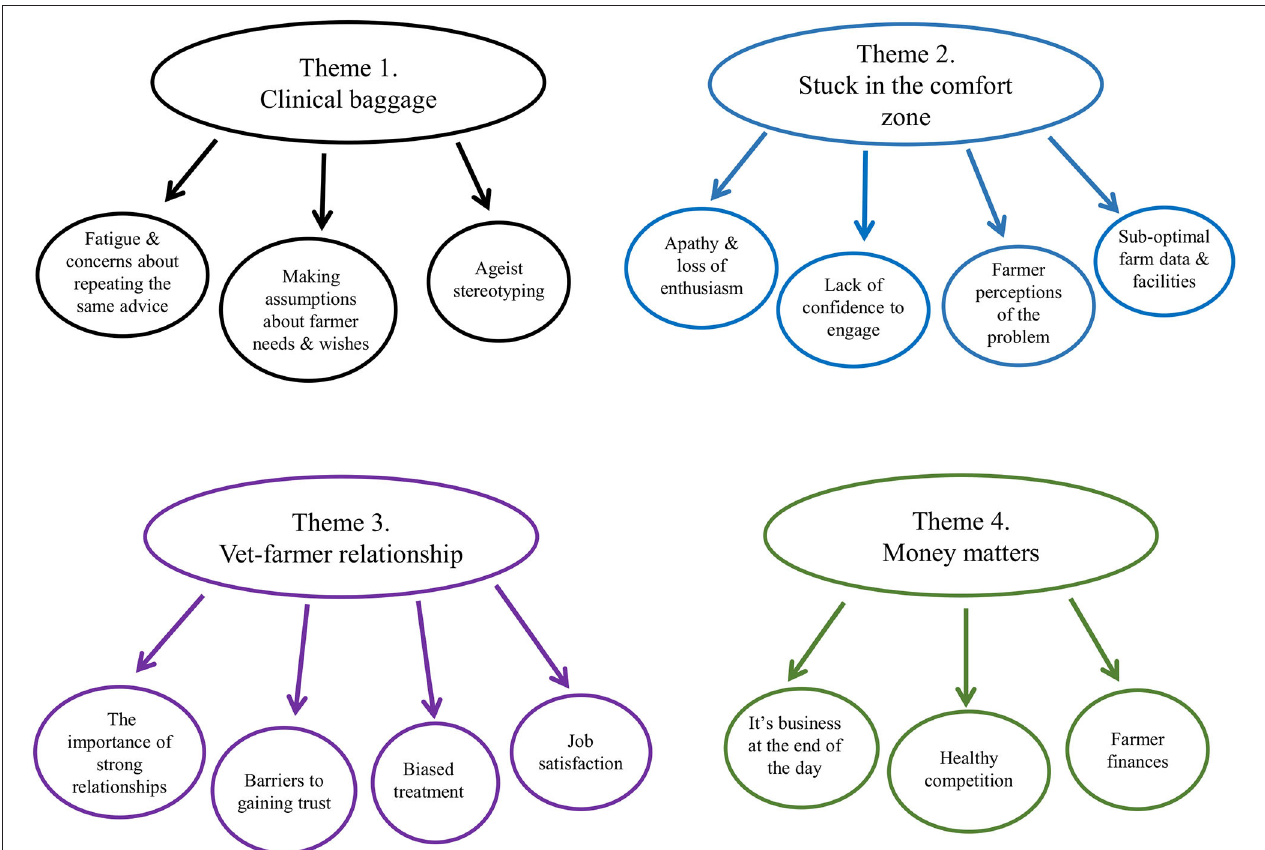
FIGURE 1 | Schematic overview of themes and sub-themes generated.